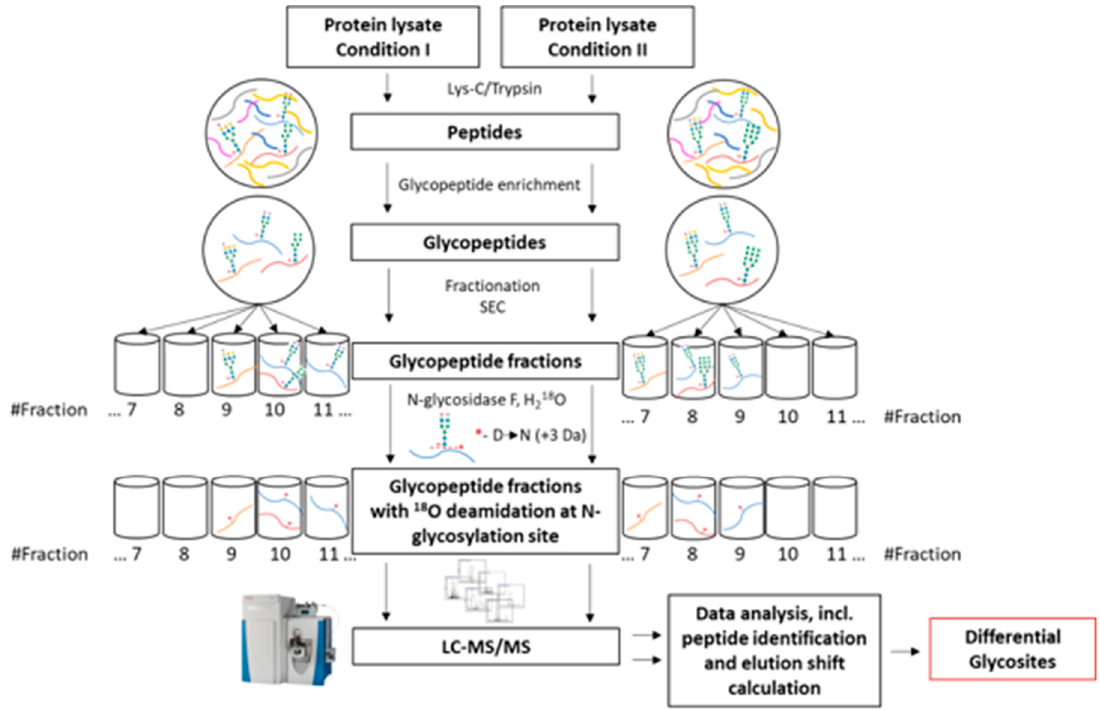
Figure 4. Differential glycosite profiling strategy. Membrane protein lysates underwent enzymatic digestion using a combination of Lys-C and trypsin followed by glycopeptide enrichment. Samples enriched in glycopeptides were then fractionated on SEC into 20 fractions. Each fraction was deglycosylated using N-glycosidase F in 18 O-water to ensure a +3 Da shift during the deglycosylation-induced deamidation of asparagine. Furthermore, each fraction was analysed by mass spectrometry (LC–MS/MS). Through complex data analysis, which led to a comparison of the elution times of the same glycopeptides in both conditions, differential glycosites were identified.